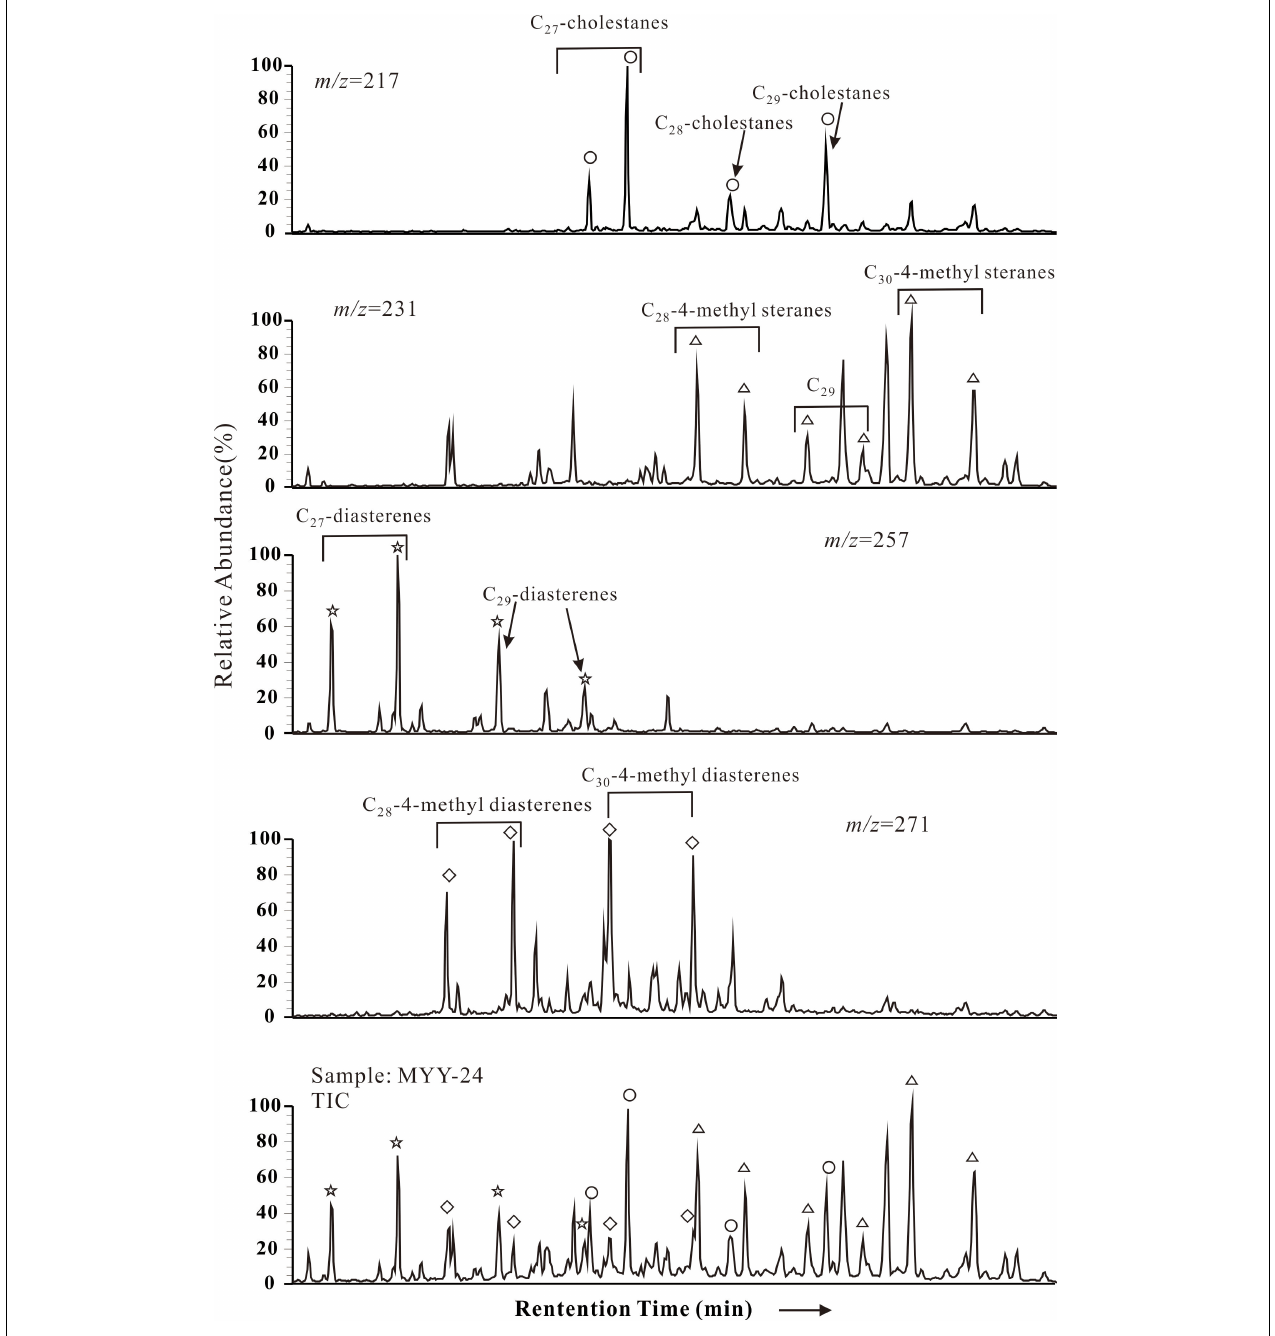
FIGURE 4 | The identification and distribution of steranes in a representative oil shale sample (Note: ◦ : regular steranes; (cid:77) : 4-methyl steranes; (cid:63) : diasterenes; ♦ : 4-methyl diasterenes; TIC: total ion chromatogram).